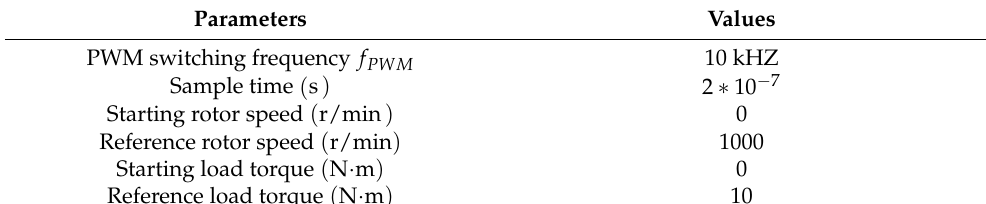
Table 1. Simulation parameters.